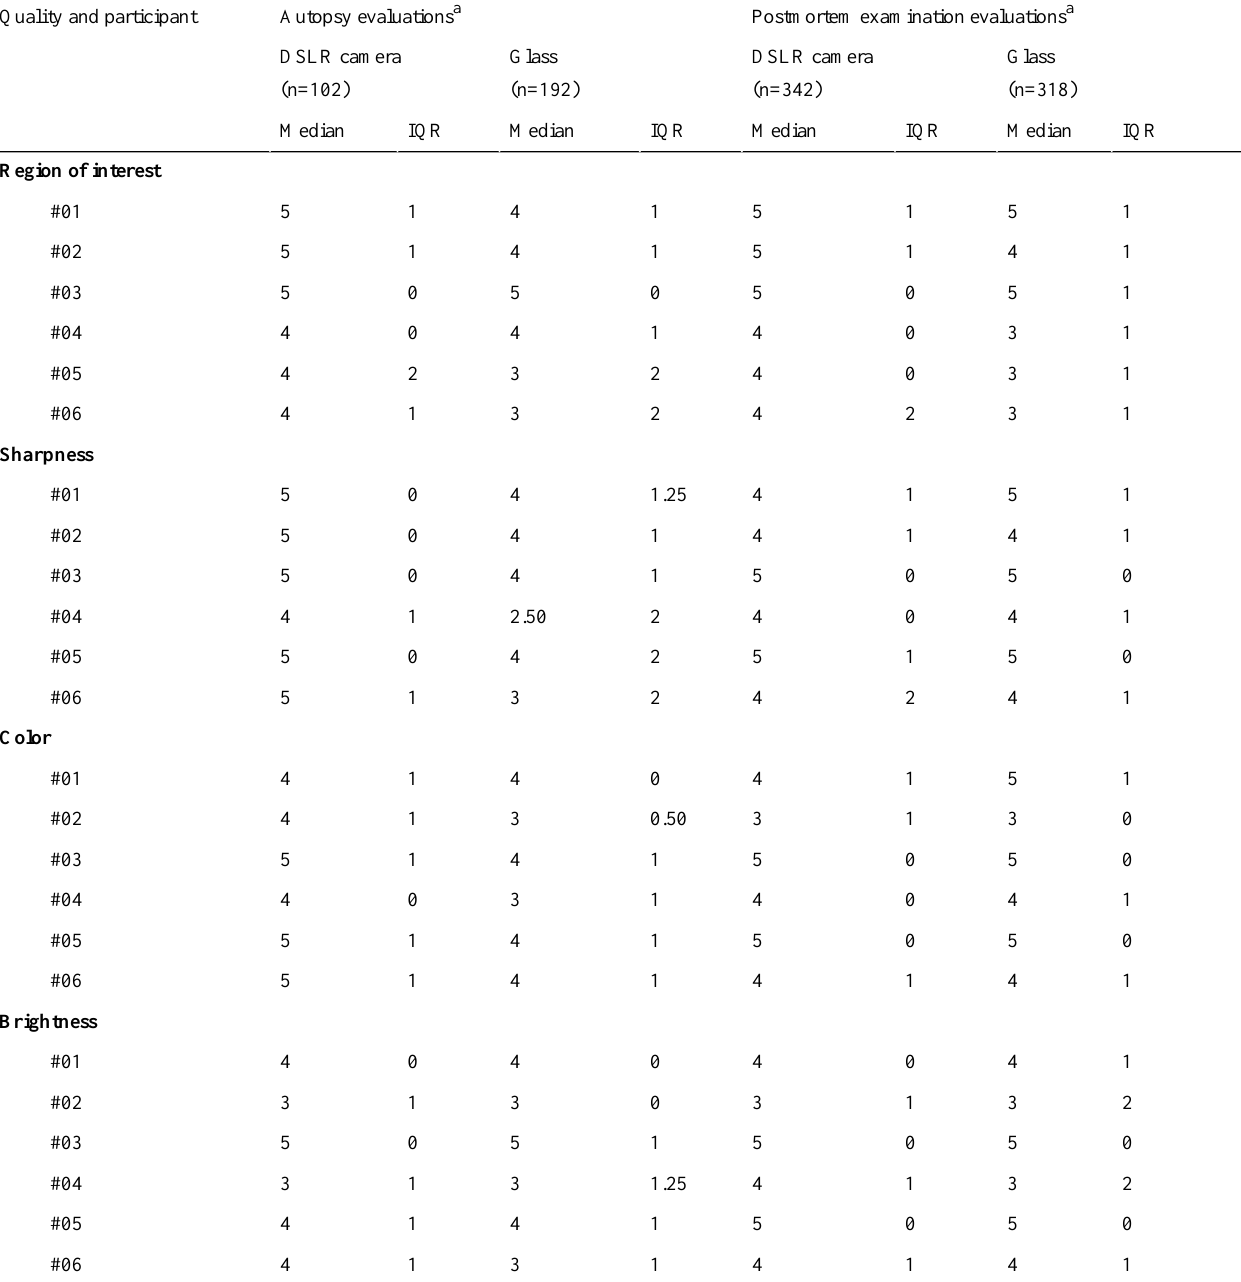
Table 3. Median values and interquartile ranges (IQR) of evaluations given by 6 raters for images taken during autopsy (n=294) and postmortem examination (n=660) with a digital single-lens reflex (DSLR) camera and Google Glass.